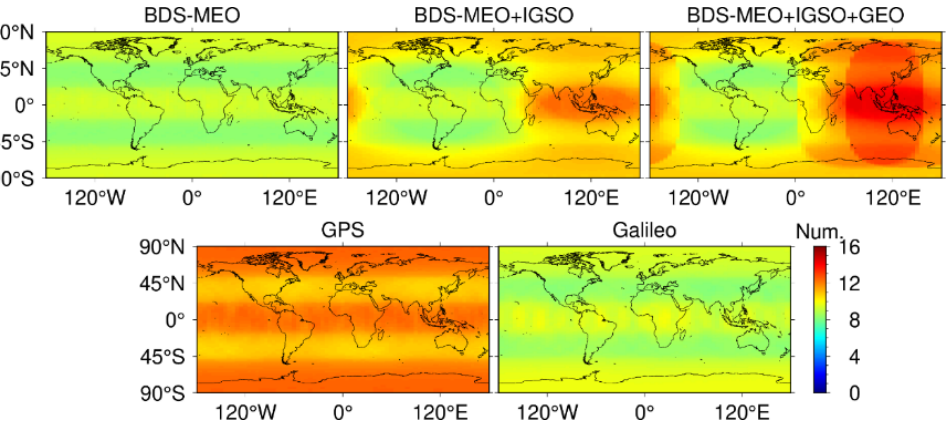
Figure 2. Number of visible satellites for GPS, Galileo, BDS-3-MEO, BDS-3-MEO+IGSO, and BDS-3- MEO+IGSO+GEO.